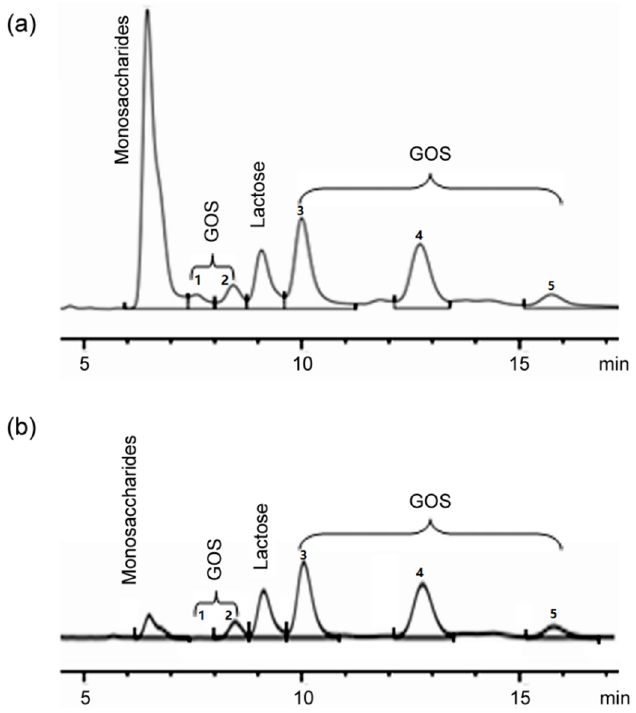
Figure 5. HPLC analysis of GOS synthesized by L. bulgaricus L3 ( a ) and treated after activated charcoal adsorption ( b ). The peaks at 6.4 min represent monosaccharides including galactose and glucose, while the peak at 9.1 min represents lactose. Peaks at 7.6, 8.4, 9.9, 12.7, and 15.7 min are all GOS products, including transglycosylated disaccharides (peaks 1, 2, and 3), trisaccharides (peak 4), and tetrasaccharide (peak 5).